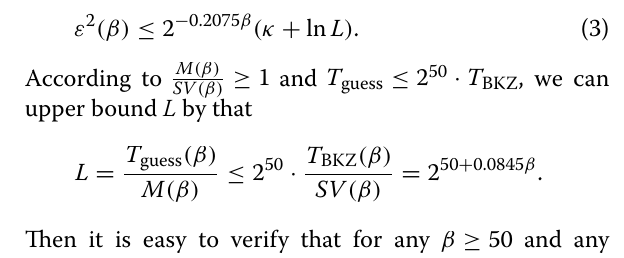
*H2M means H ybrid 2 m in this table